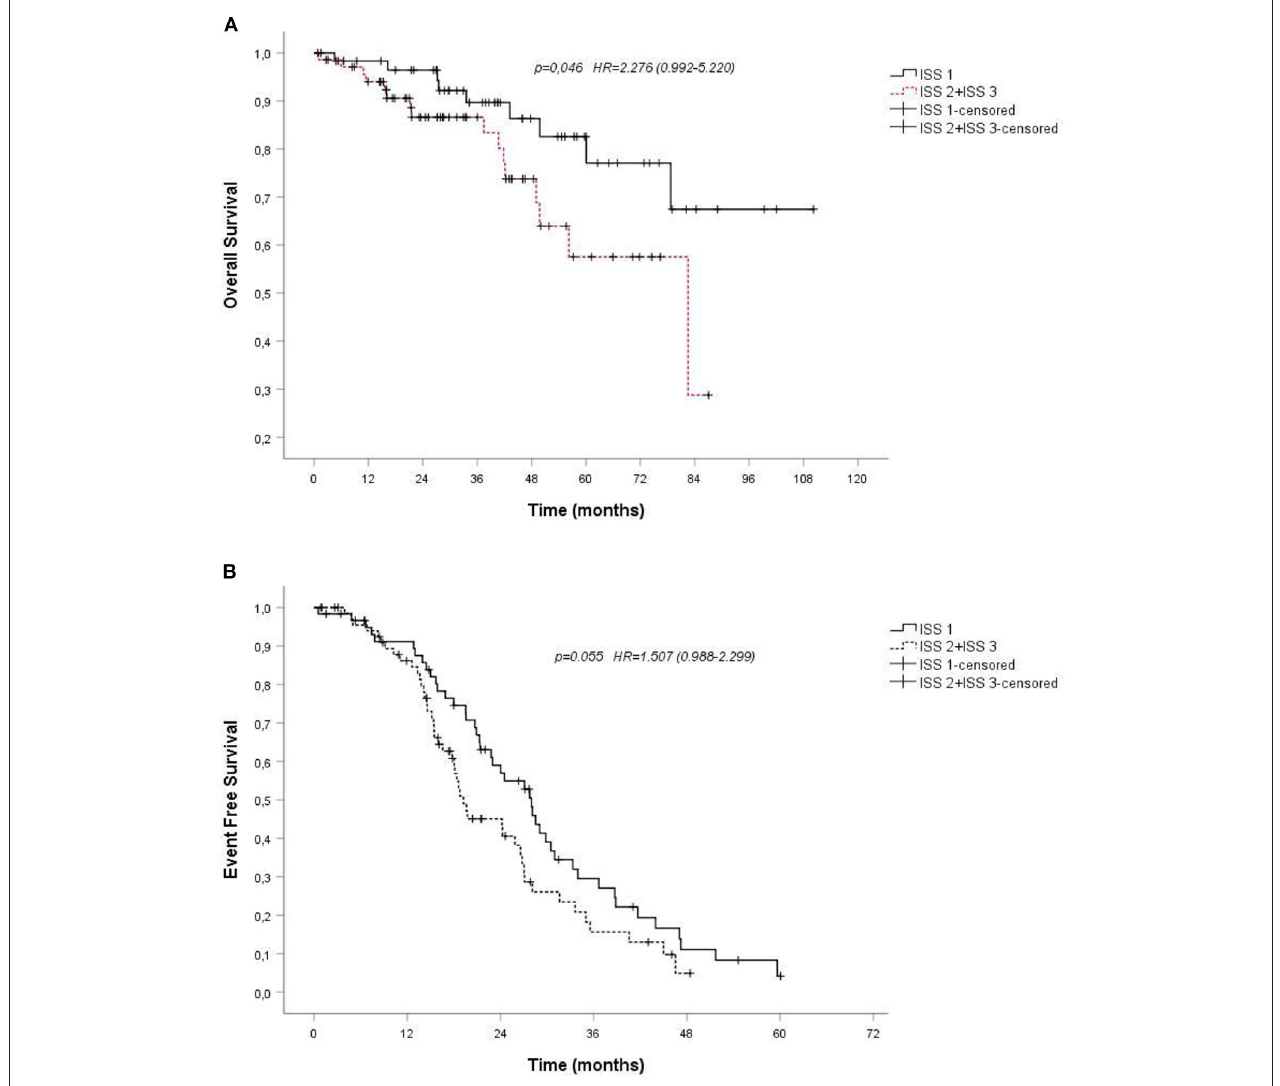
FIGURE 3 | (A) . Overall survival (OS) by Kaplan-Meier estimates in patients with multiple myeloma treated with VMP, depending on International Staging System (ISS); (B) . Probability of event-free survival (EFS) by Kaplan-Meier estimates in patients with multiple myeloma treated with VMP, depending on International Staging System (ISS). VMP, bortezomib plus